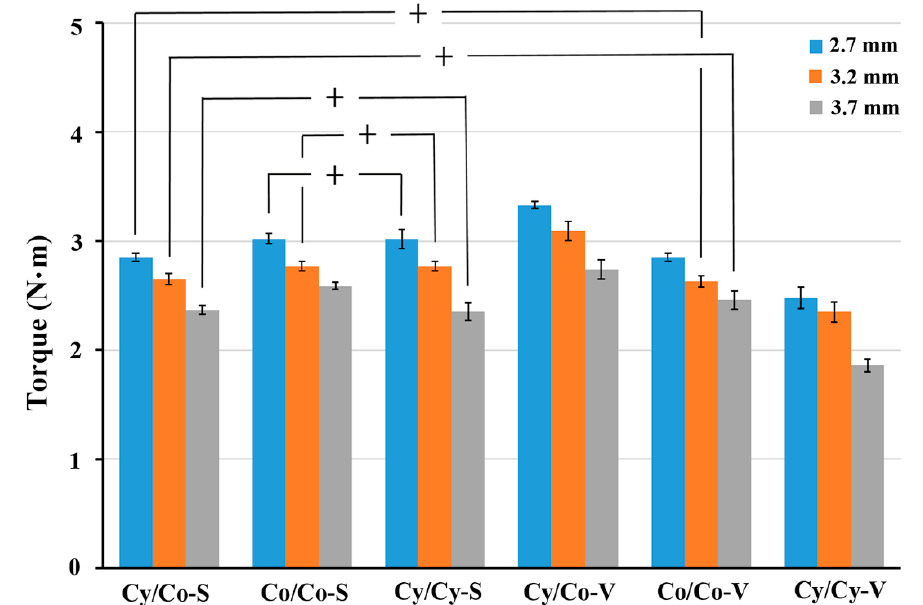
Figure 7. Mean maximal insertional torque for screws of various geometries inserted in 2.7-mm, 3.2-mm and 3.7-mm pilot holes using 20-pcf test blocks. Groups without significant differences are indicated with the “+” symbol.